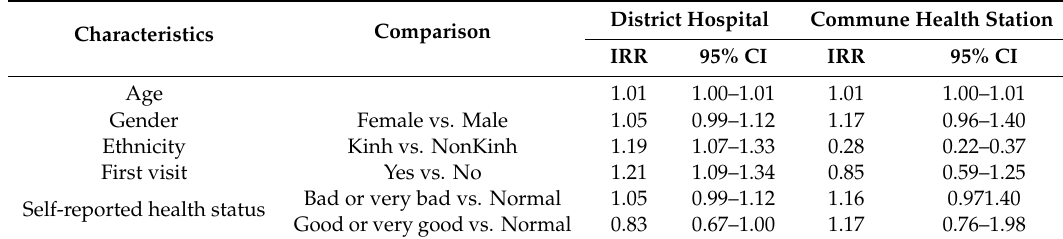
Table2. Multivariatelinearregressionoftheoutpatientwaitingtimeaccordingtoselectedsocioeconomic